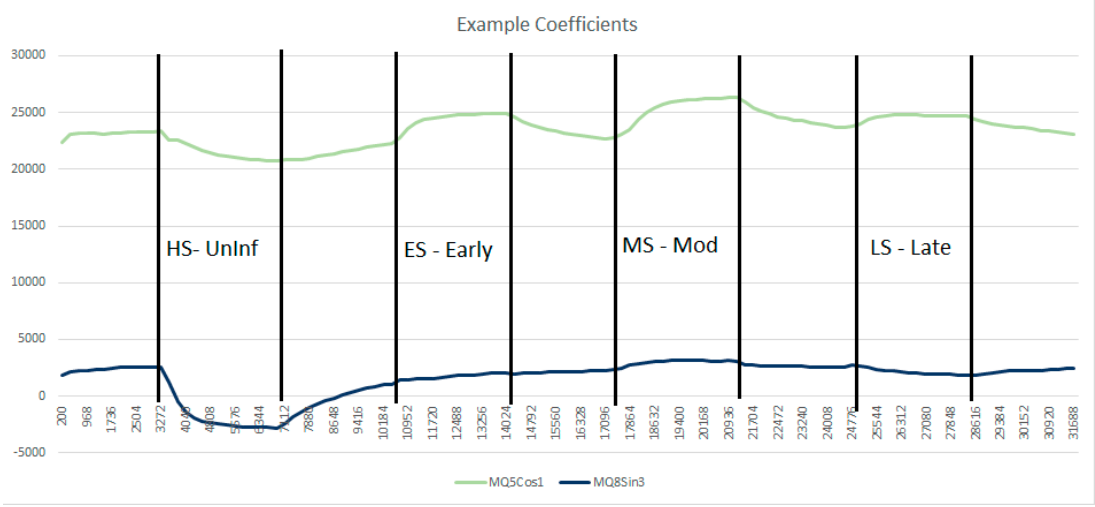
Figure 6. Evolution of MQ5 Cos1 and MQ8 Sin3 during the first experiment.